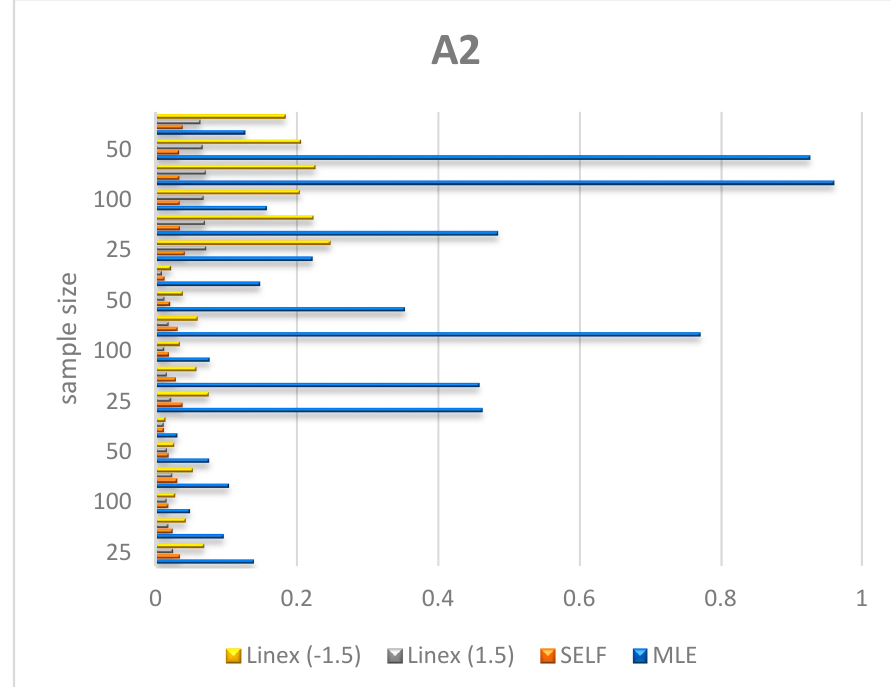
Figure 7. Plot A2 of 𝜆 by results in Table 1.